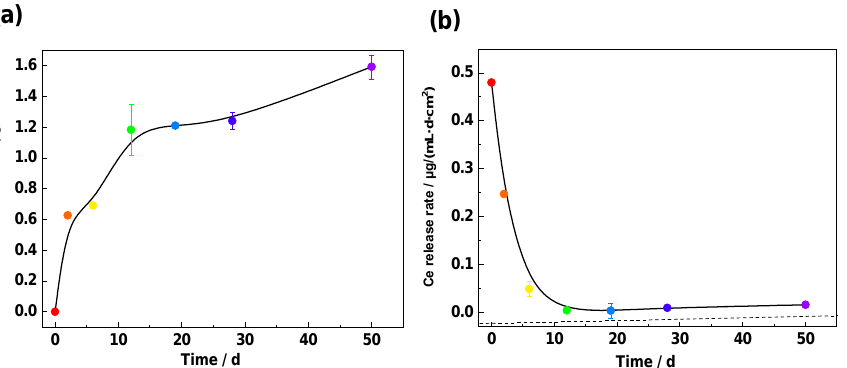
Figure 11. Cerium ions release from the epoxy coatings containing 5 wt% CeTar in 3.5% NaCl solu- tion: ( a ) Cerium ions concentration in the solution; ( b ) Cerium ions release rate. ( a ) Cerium ions concentration in the solution; ( b ) Cerium ions release